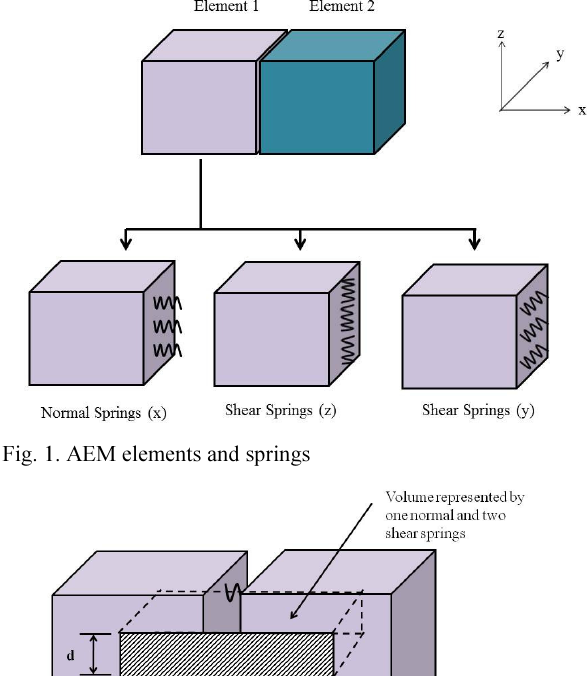
Fig. 2. Connection of two elements in the AEM